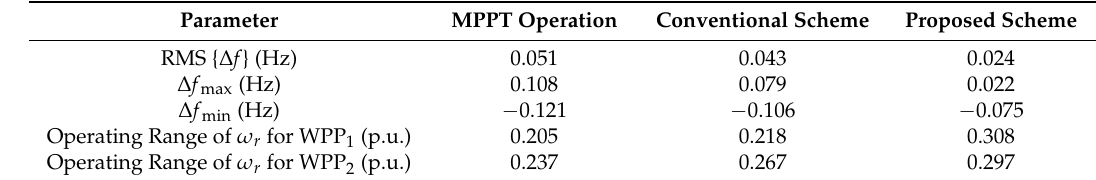
Table 1. Results for Case 1. RMS: root mean square.